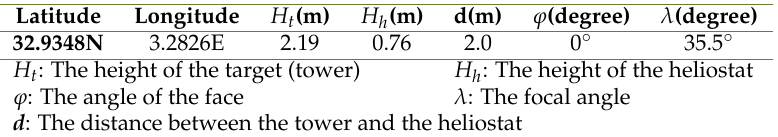
Table 5. Location geographical data and heliostat-tower parameters